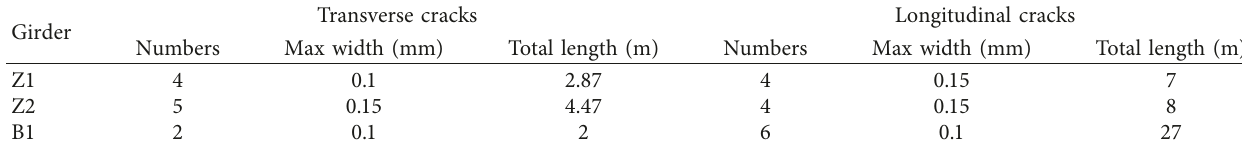
Table 1: Cracks of the test girders.